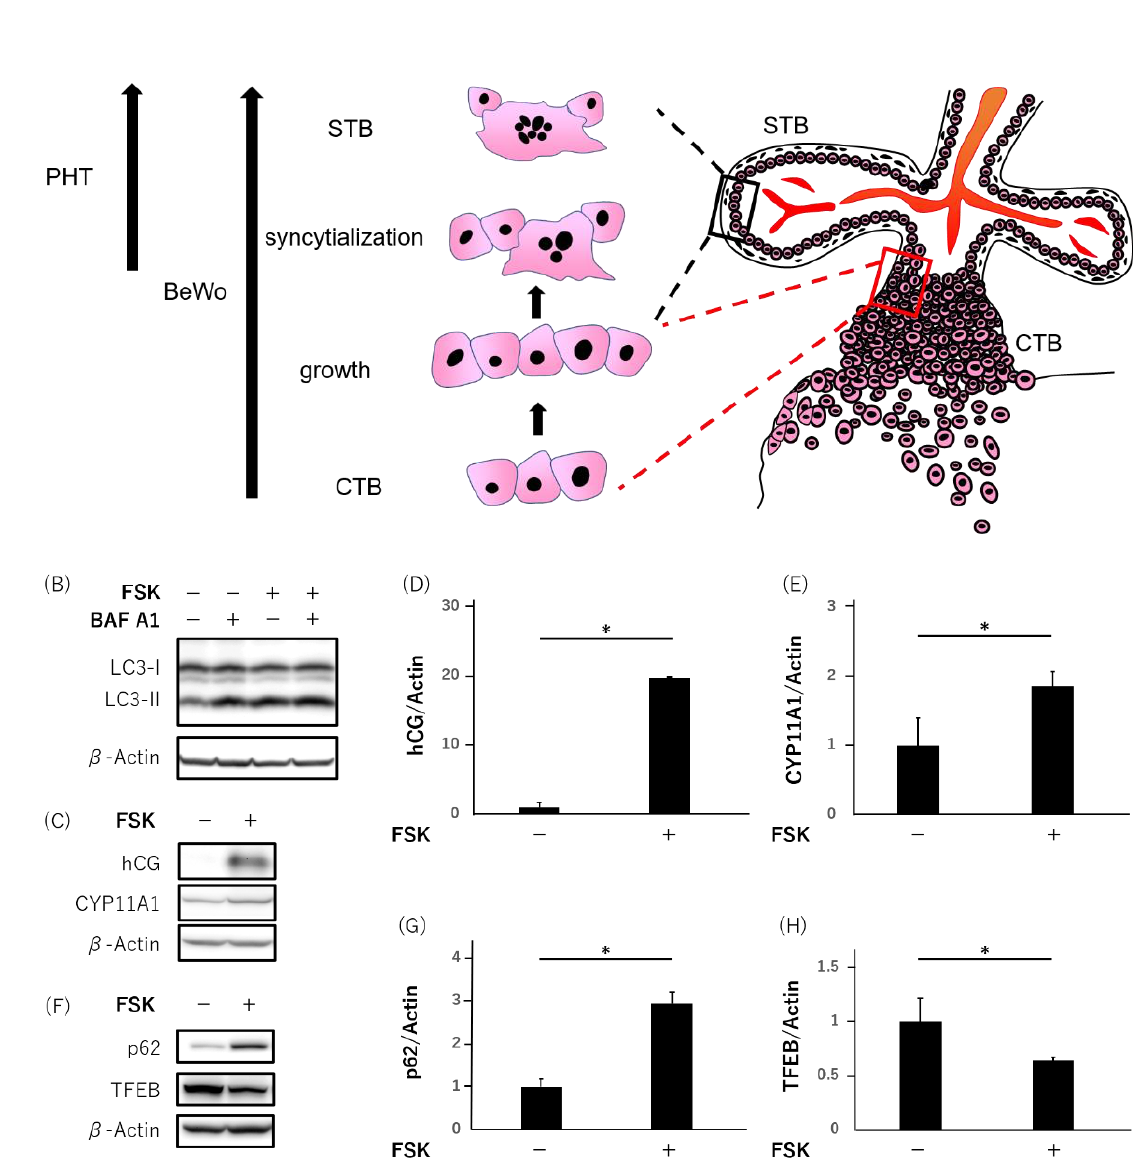
Figure 2. A decrease in autophagic activity in BeWo cells during differentiation was due to TFEB reduction. The schema indicated the differential properties of BeWo cells and primary human trophoblasts (PHT) in the flow of syncytialization, cytotrophoblasts (CTB) to syncytiotrophoblast (STB). The red rectangle indicated growing of CTB, and the black rectangle indicated fusion of STB ( A ). BeWo cells were treated with Forskolin (FSK, 25 μ M) to induce syncytialization. LC3 was evaluated to assess autophagy flux in the presence of Bafilomycin A1 (BAF A1 20 nM) ( B ). Protein expressions of hCG and CYP11A1 were evaluated as an indicator of differentiation ( C ). The graphs showed the quantified protein levels of hCG ( D ) and CYP11A1 ( E ). Protein expressions of p62 and TFEB were evaluated to assess autophagy regulatory proteins during differentiation in the presence of FSK ( F